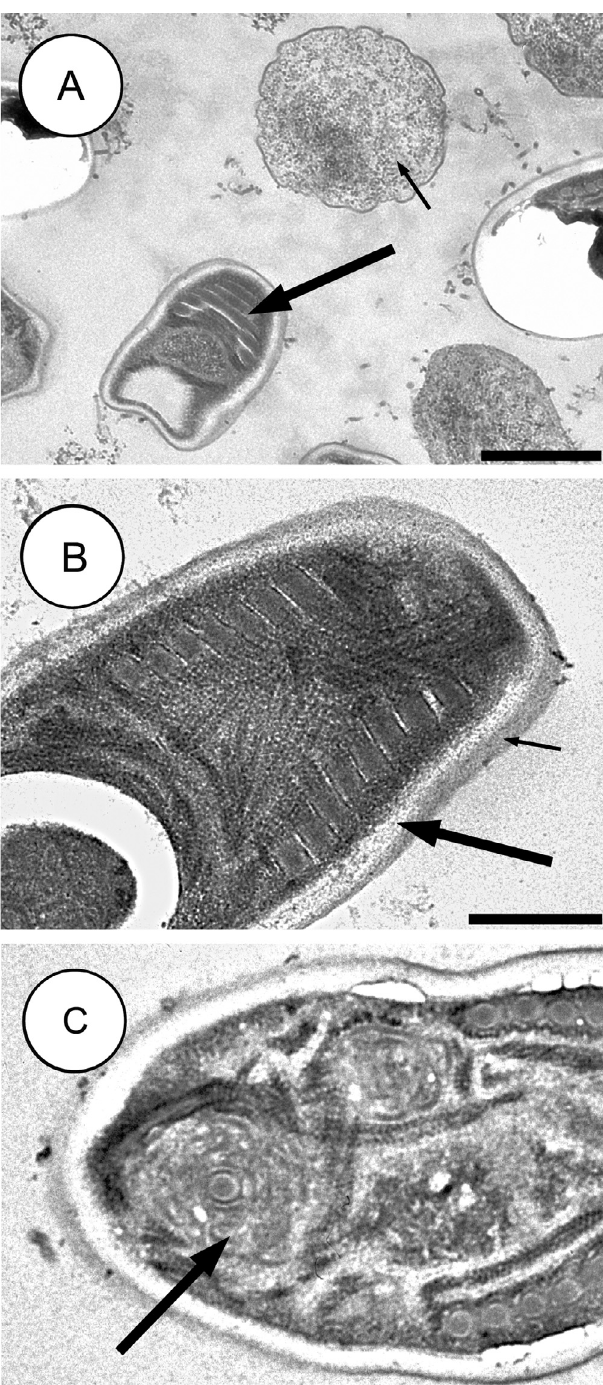
Figure 5. Dictyocoela diporeiae n. sp., transmission electron micrograph of the microsporidian infecting Diporeia sp. in Lake Superior. Notice (A) the meront (small arrow) and mature spore (large arrow), (B) spore wall composed of a thick electron-lucent endospore (large arrow) overlaid with a thinner electron-dense exospore (small arrow), and (C) lamellar polaroplast composed of ordered concentric membranes surrounding the polar filament (large arrow). Scale bars: A = 1000 nm, B–C = 500